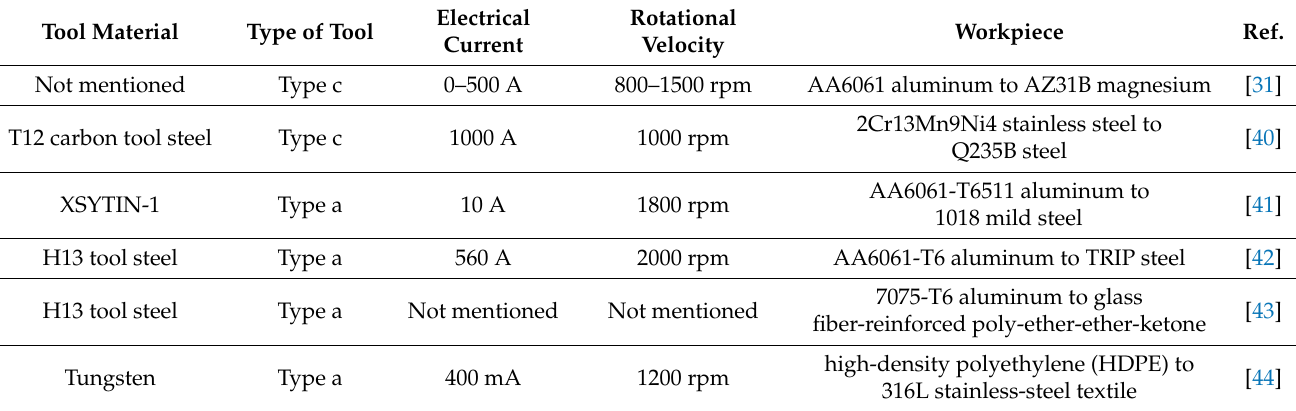
Table 2. Used tools and process parameters in EA-FSW of dissimilar